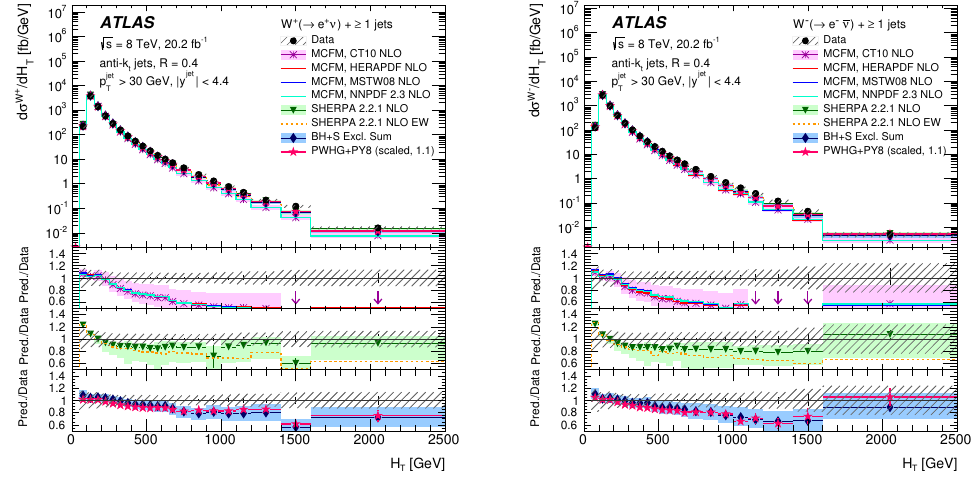
Figure 21 . Di(cid:11)erential cross sections for the production of W + (left) and W (cid:0) (right) as a function of the H T for events with N jets (cid:21) 1. For the data, the statistical uncertainties are indicated as vertical bars, and the combined statistical and systematic uncertainties are shown by the hatched bands. The uppermost panel in each plot shows the di(cid:11)erential cross sections, while the lower panels show the ratios of the predictions to the data. The theoretical uncertainties on the predictions are described in the text. The arrows on the lower panels indicate points that are outside the displayed range.